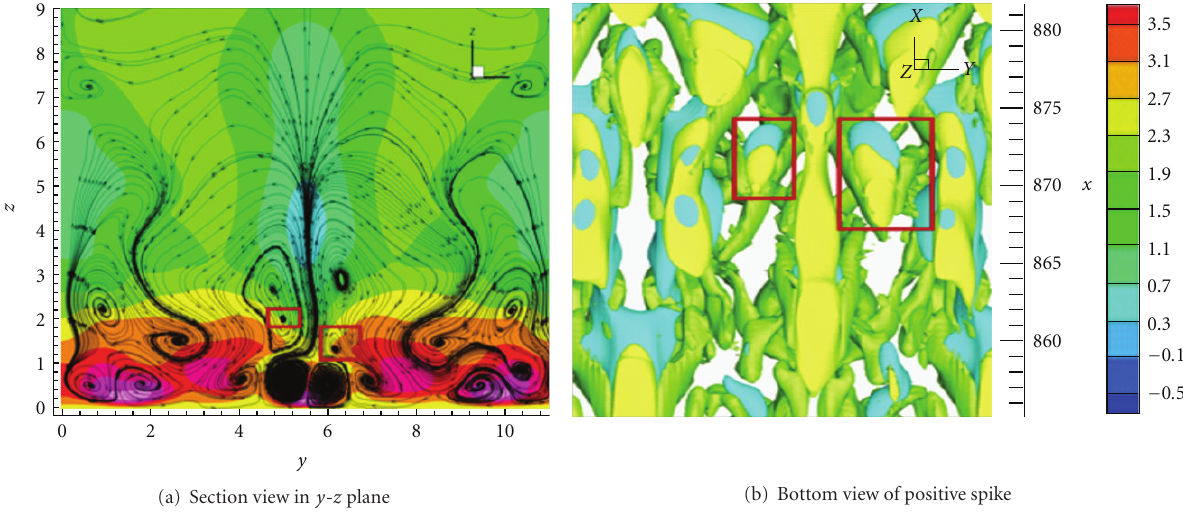
Figure 35: The flow lost symmetry in second level rings and bottom structure at t = 15 . 0 T .